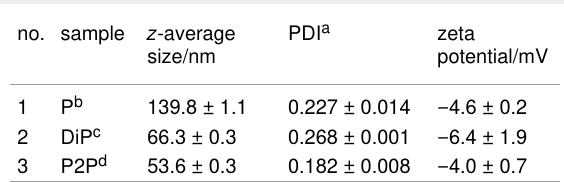
Table 2: Characterization of different